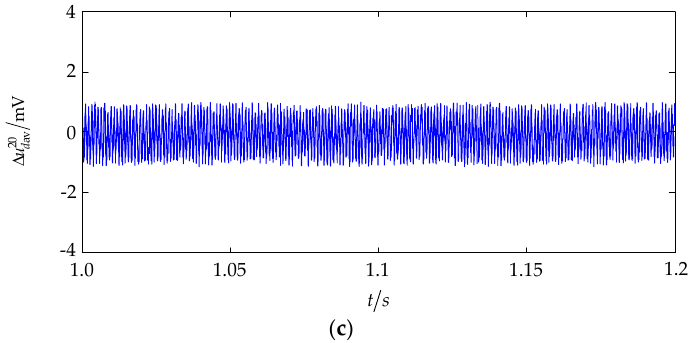
Figure 20. The waveforms about the d -axis voltage under normal conditions: ( a ) The d -axis voltages of two sets of windings; ( b ) ∆ u d ; ( c ) ∆ u d av